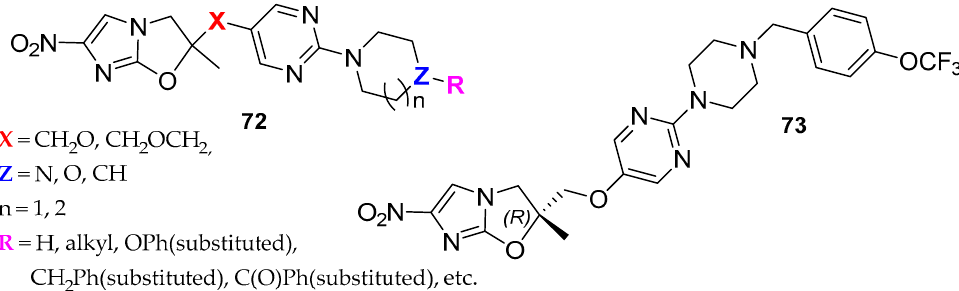
Figure 19. Delamanid analogues 72 and 73 with pyrimidine replacement for linking phenyl ring.